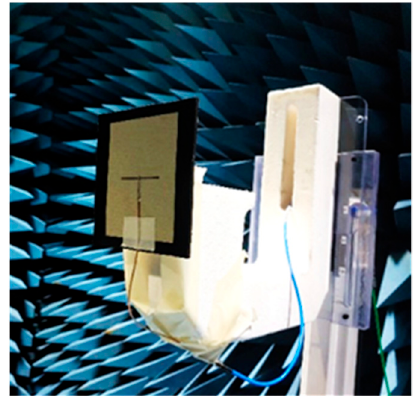
Figure 7. Antenna prototype mounted in an anechoic chamber.